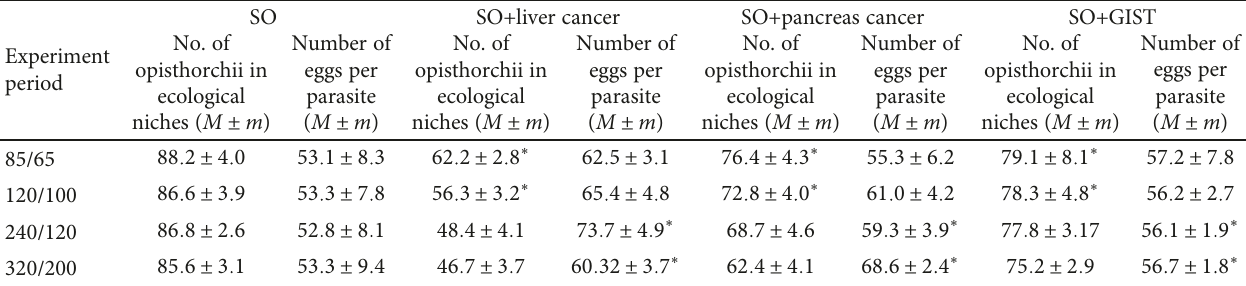
Table 2: Dynamics of the infestation intensity and egg production of O. felineus in carcinogenesis (experiment).